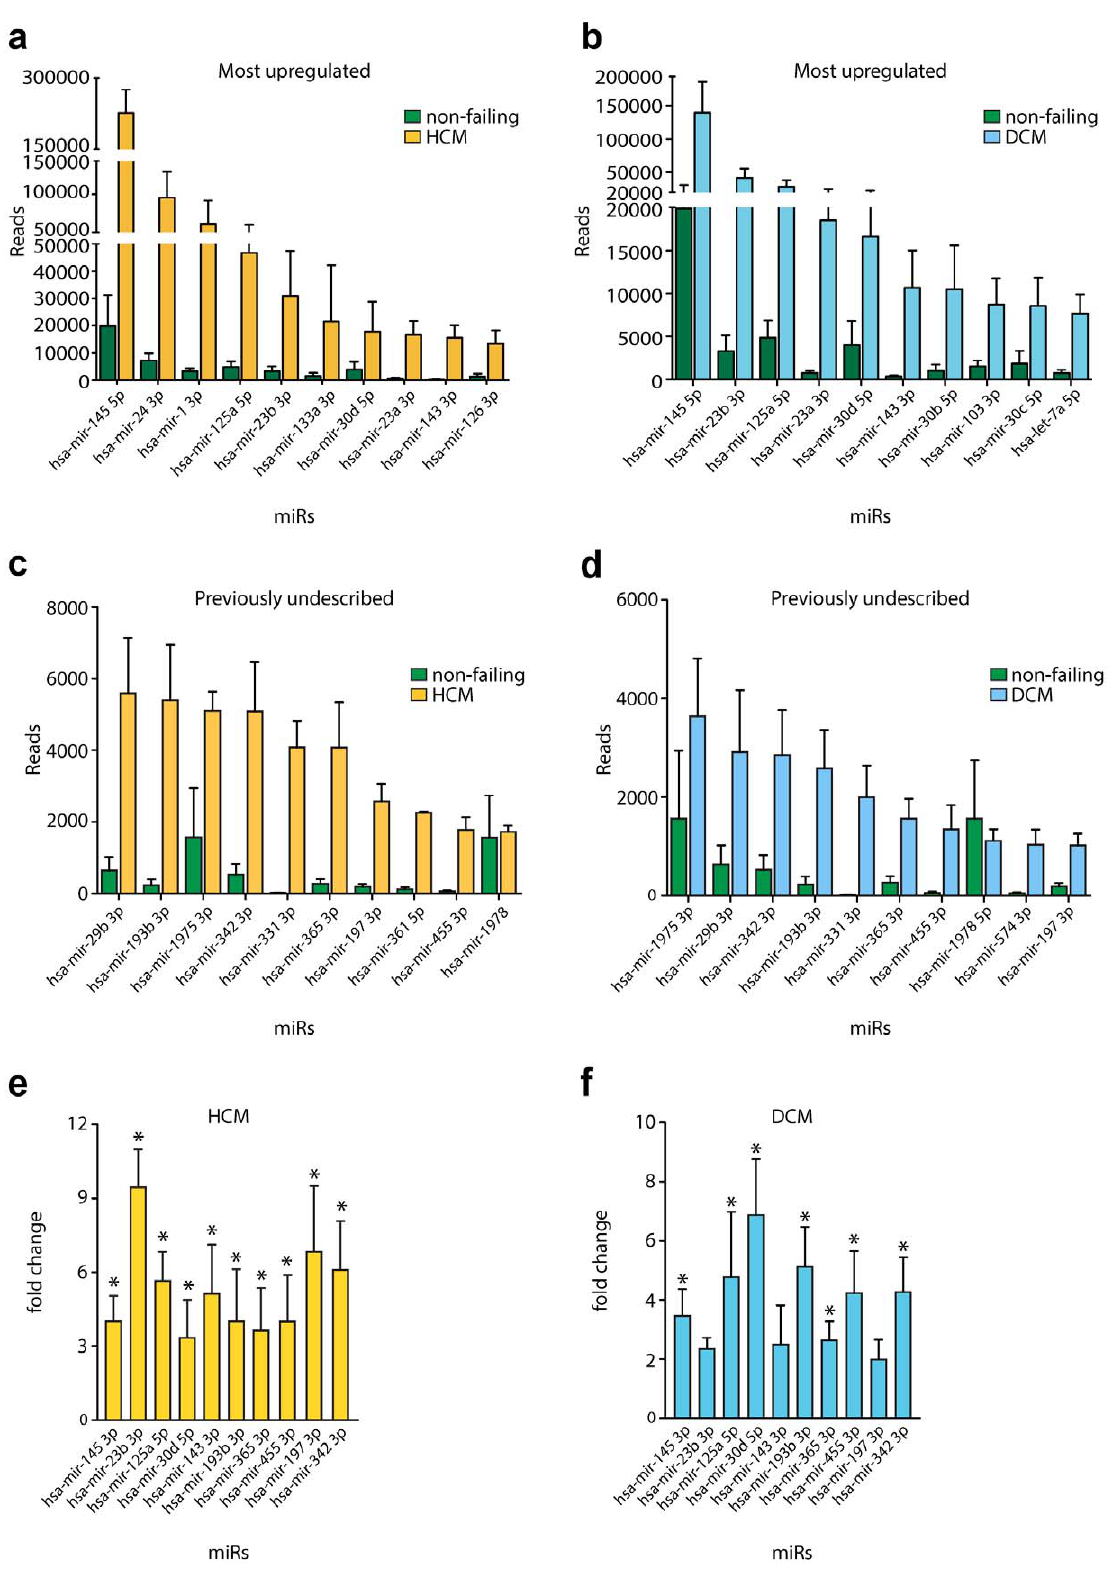
Figure 2. Hypertrophic cardiomyopathy (HCM) and dilated cardiomyopathy (DCM) present different microRNA expression patterns. Expression pattern of the 10 most upregulated microRNAs that have been previously related to cardiovascular disease and/or described in literature ( A , B ) or not ( C , D ), in the HCM and DCM libraries. E , F , Real time quantitative PCR analysis to validate results from A – D .